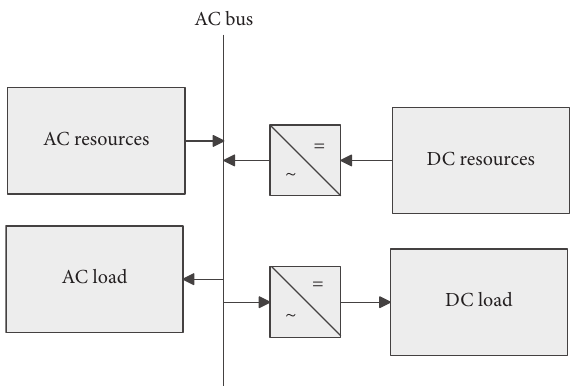
Figure 4: Centralized AC bus configuration.